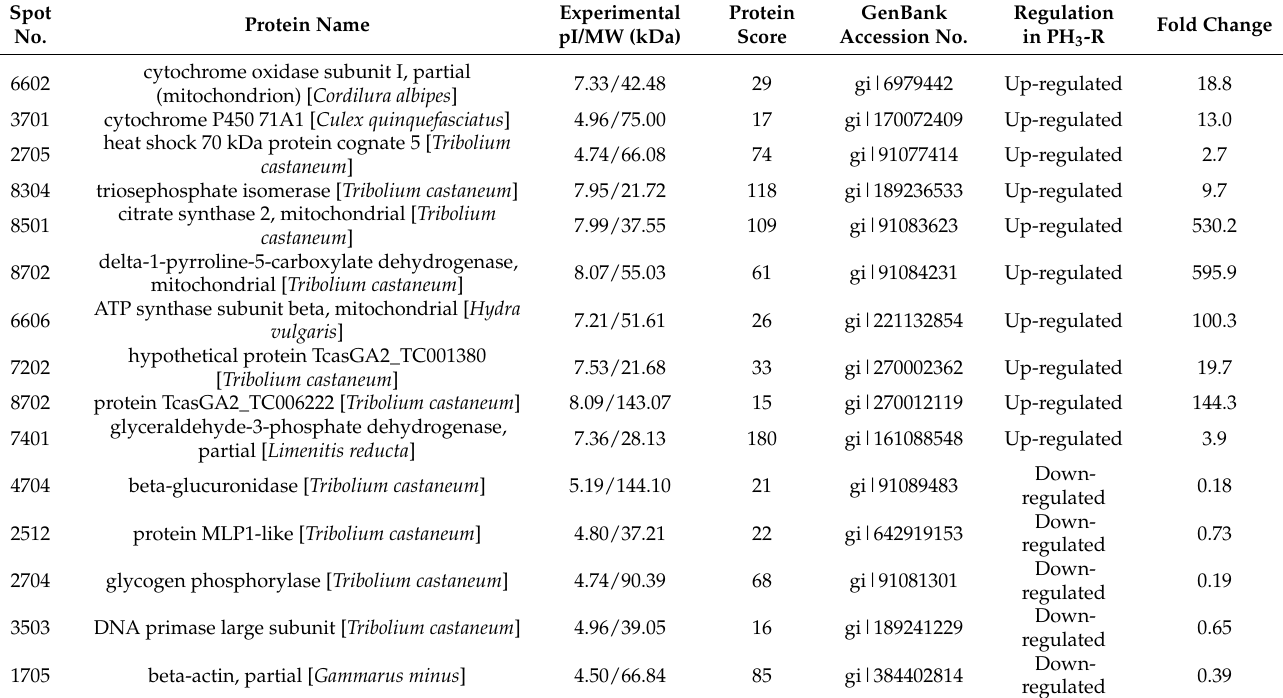
Table 1. Identification of differentially expressed proteins using